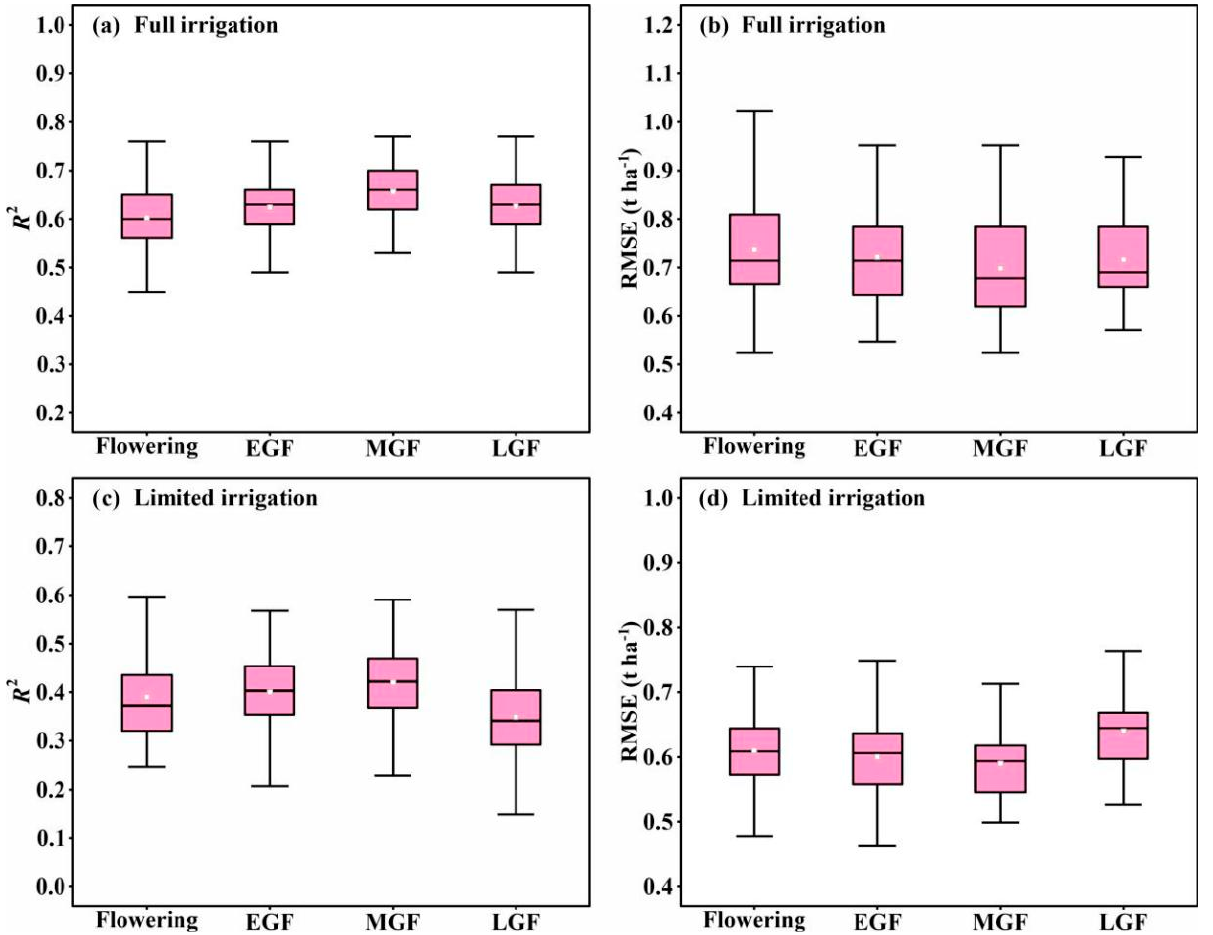
Figure 3. ( a – d ) The statistical distributions of model performance for predicting grain yield of four individual growth stages. Abbreviations: EGF, early grain fill; LGF, late grain fill; MGF, mid grain fill.